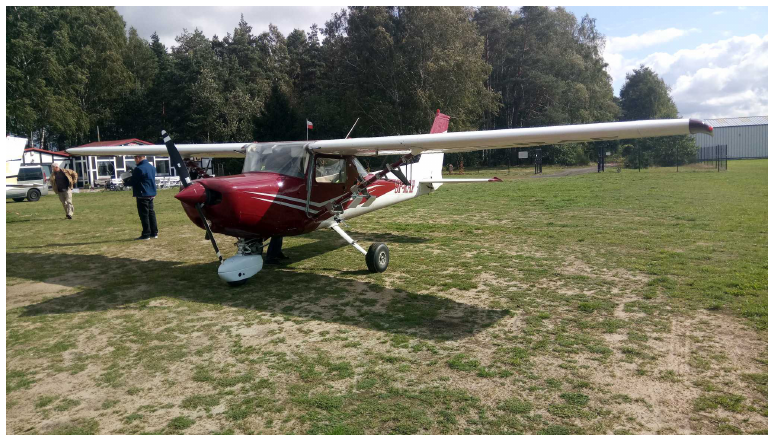
Figure 3. Radar demonstrator during measurements.